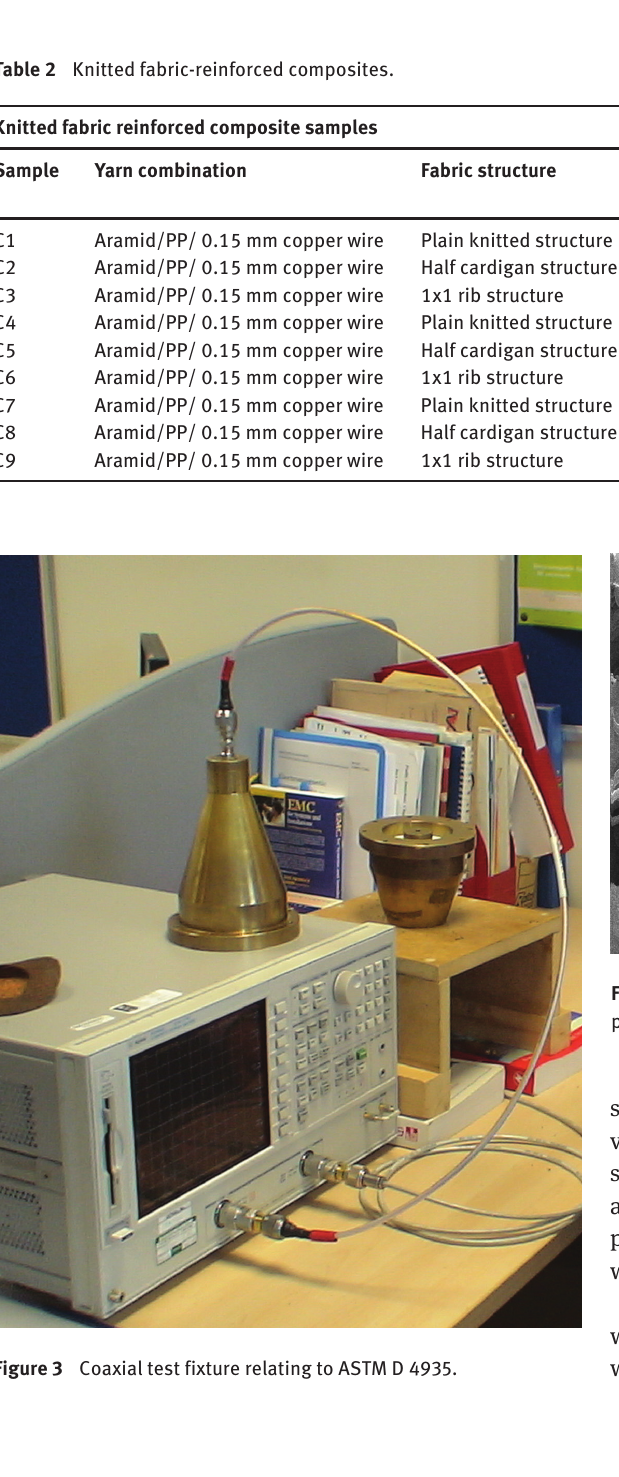
Figure 2 Fabric samples of three different structures.